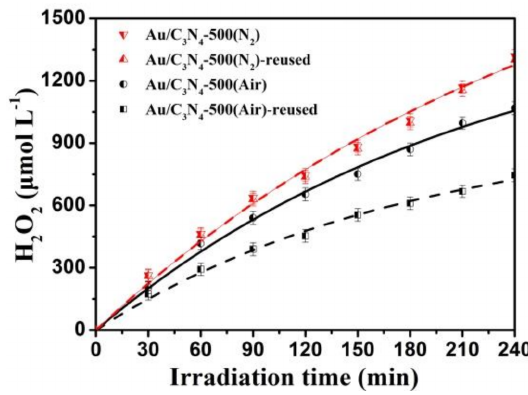
Figure 7. The repeated use of Au/C 3 N 4 -500(N 2 ) and Au/C 3 N 4 -500(Air) for H 2 O 2 generation. The experimental conditions: 1 g/L of photocatalyst, pH 3.0, 5% vol of 2-propanol, Xe lamp, illumination intensity of 100 mW/cm 2 , and O 2 -equilibrated